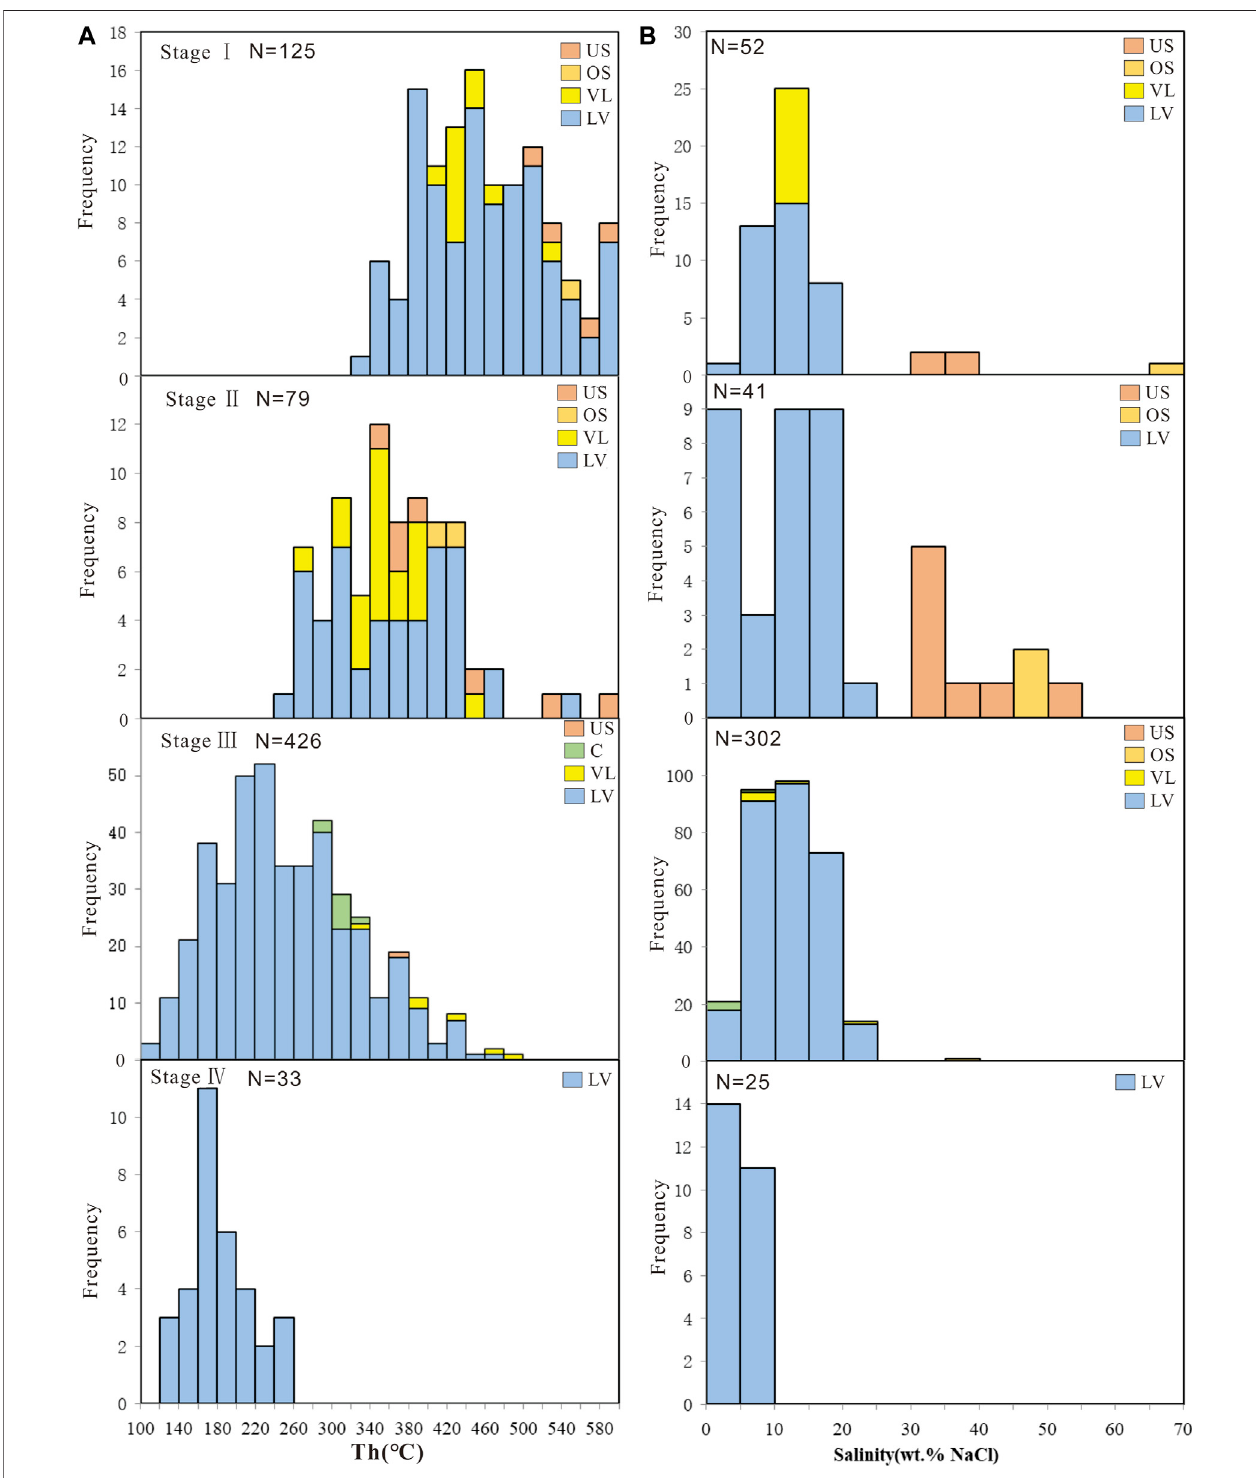
FIGURE 5 | Histogram of the relative frequencies of the homogeneous temperature (A) and salinity (B) of fl uid inclusions in each stage of the Gejiu Sn – Cu polymetallic deposit.